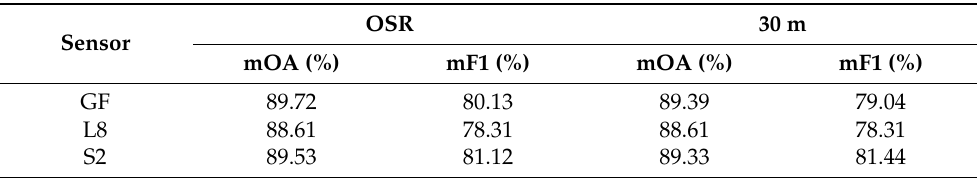
Table 6. Classification accuracy of remote-sensing data from different sensors. Only B, G, R, and NIR bands are